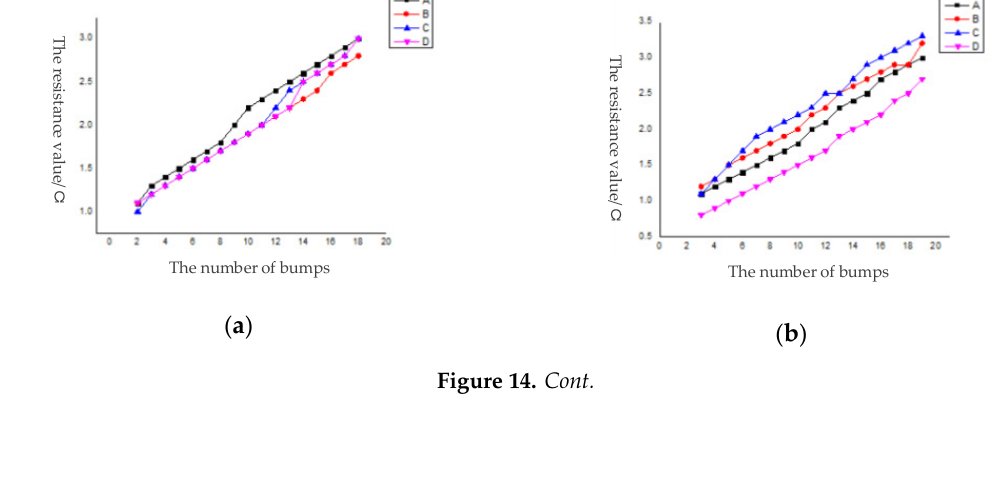
Figure 13. Result of the binding test after optimization of parameters.